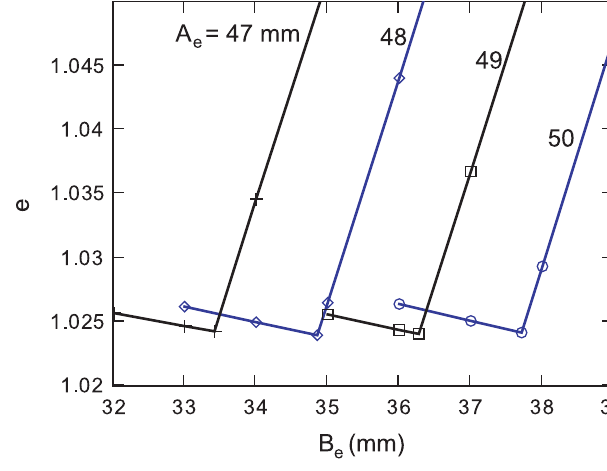
= 2 E acc for the type a end cell alone and pk